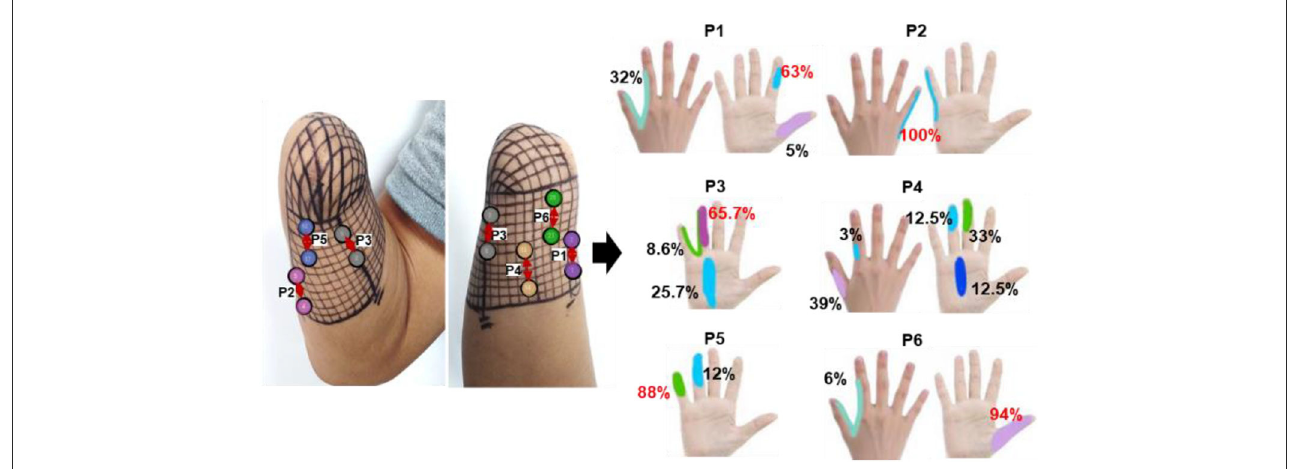
FIGURE9 The positions of evoked sensations when the six selected positions were stimulated by TENS under the MS mode.